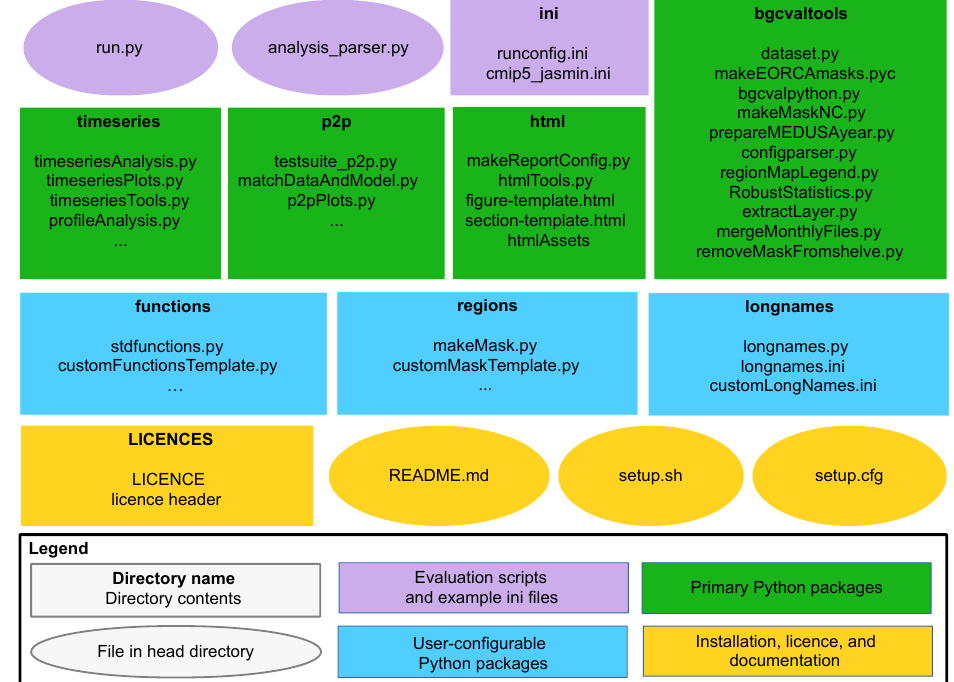
figure-template.html section-template.html